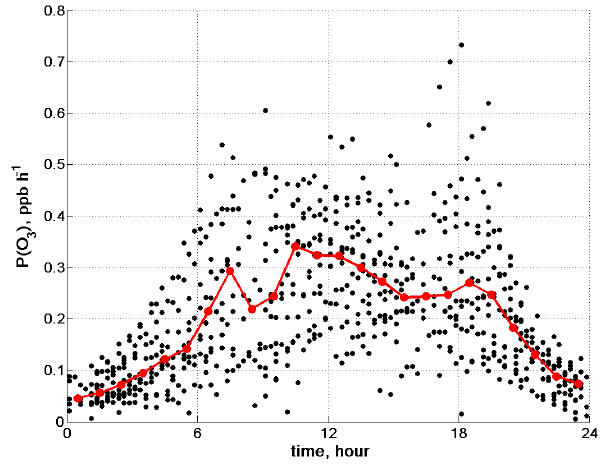
Figure 11. Ozone production calculated from measured [RO 2 ] and [NO]: red line represents hourly median